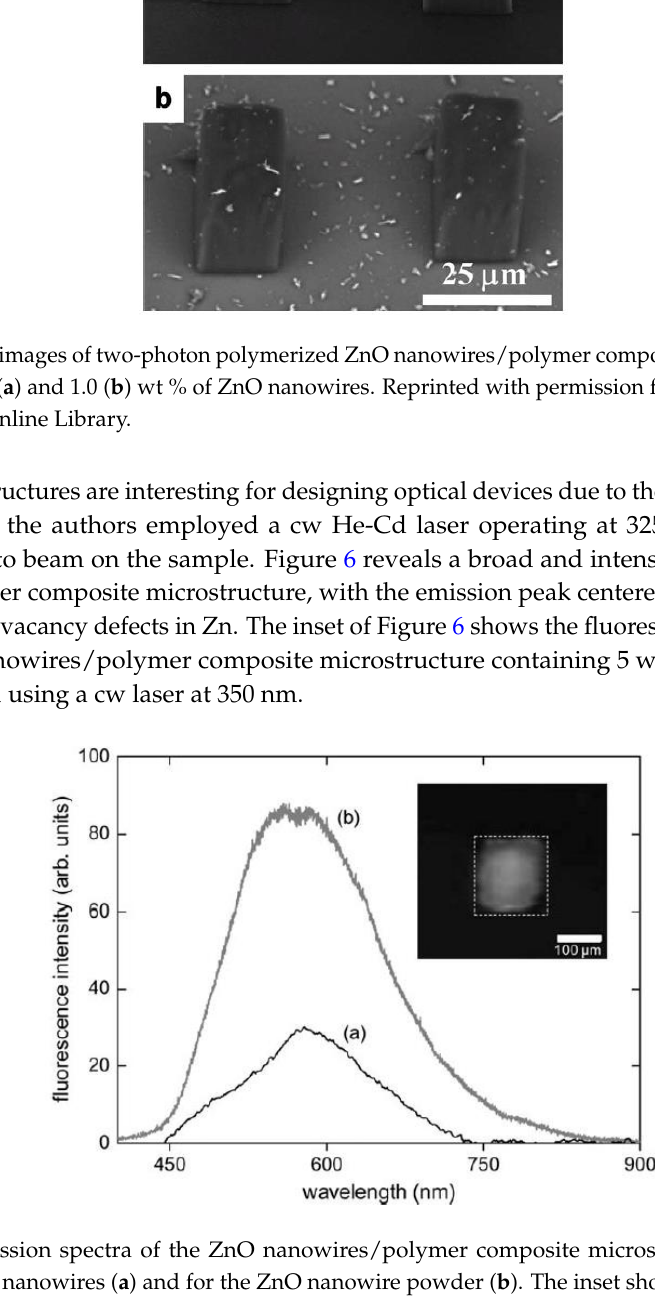
Figure 6. Emission spectra of the ZnO nanowires/polymer composite microstructure containing 5 wt % of ZnO nanowires ( a ) and for the ZnO nanowire powder ( b ). The inset shows the fluorescence image (top view) of a cubic microstructure containing ZnO. Reprinted with permission from [65]. Copyright (2014) Wiley Online Library.